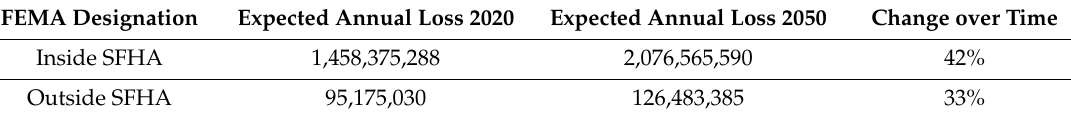
Table 3. The total expected loss inside and outside of SFHA flood hazard area.